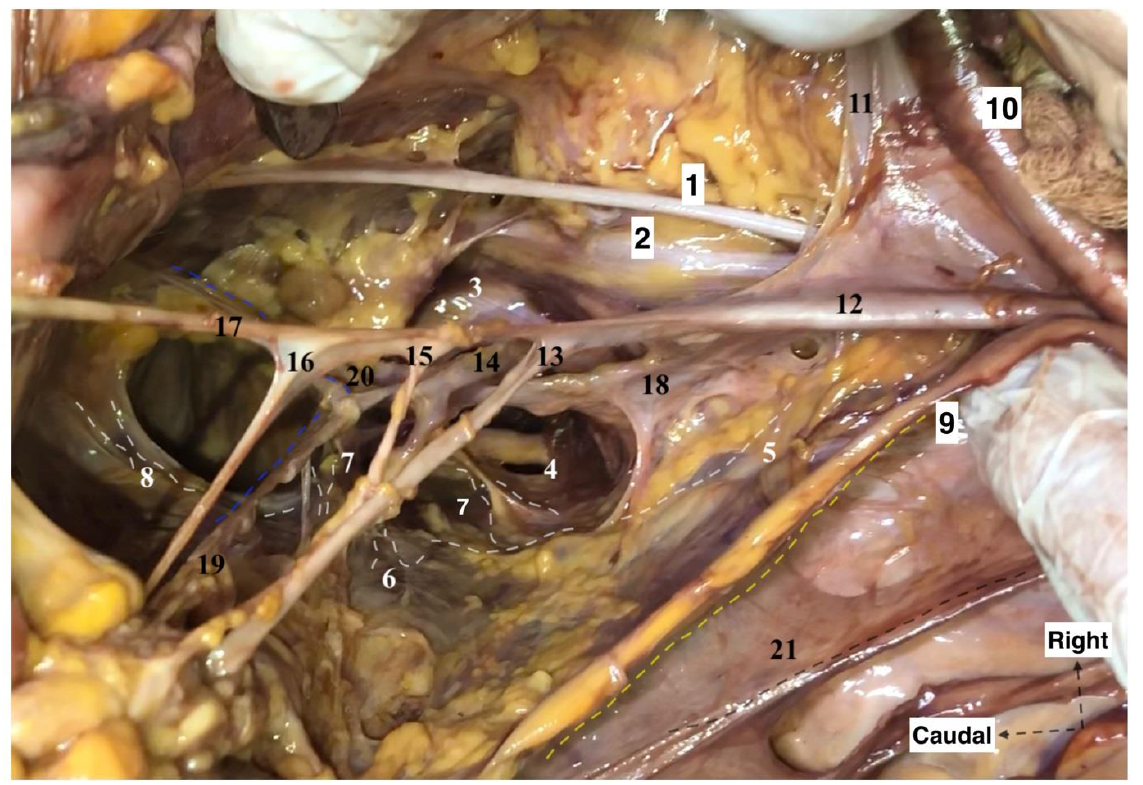
Figure 3. Right pelvic sidewall anatomy regarding the avascular, vascular and nerve compartments (cadaveric dissection by Dr. Ilker Selcuk). 1. Right obturator nerve, 2. Lumbosacral trunk, 3. S1 nerve, 4. S2 nerve, 5. Hypogastric nerve, 6. Inferior hypogastric plexus, 7. Pelvic splanchnic nerve bundles, 8. Radiating fibers of inferior hypogastric plexus under the terminal ureter at the paracolpium, 9. Ureter, 10. External iliac artery, 11. External iliac vein, 12. Internal iliac artery, 13. Uterine artery, 14. Pudendal artery, 15. Superior vesical artery, 16. Inferior vesical artery, 17.Obliterated umbilical artery, 18. Internal iliac vein, 19. Deep uterine vein, 20. Obturator vein, 21. Cut end of broad ligament — posterior leaf.